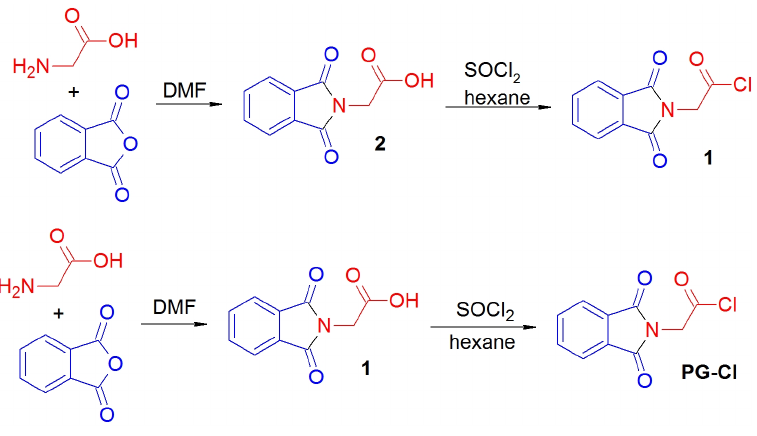
Figure 2. Scheme of N -phthaloylglycine chloride synthesis.